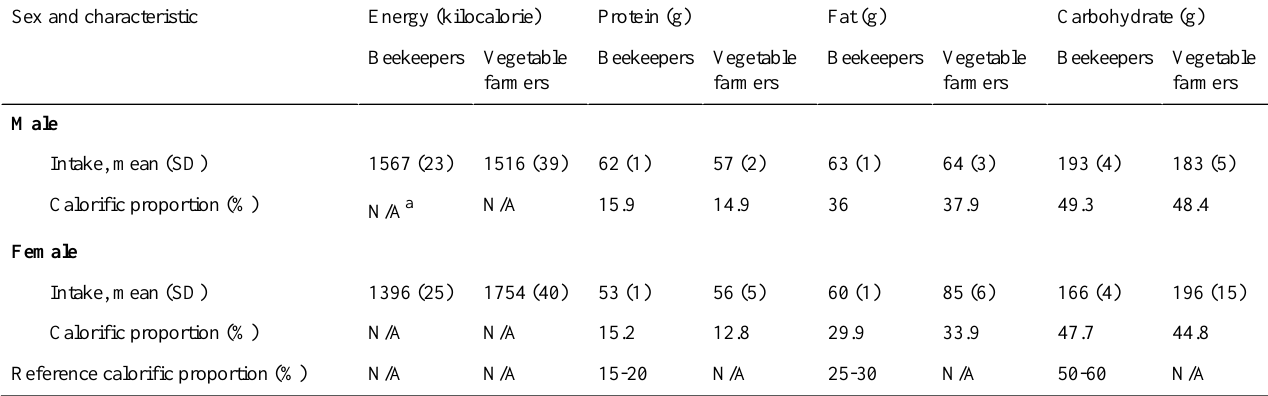
Table 4. Mean daily energy and intake of 3 major heat-producing nutrients of beekeepers and vegetable farmers from Wuhan, China (sampled period February-April